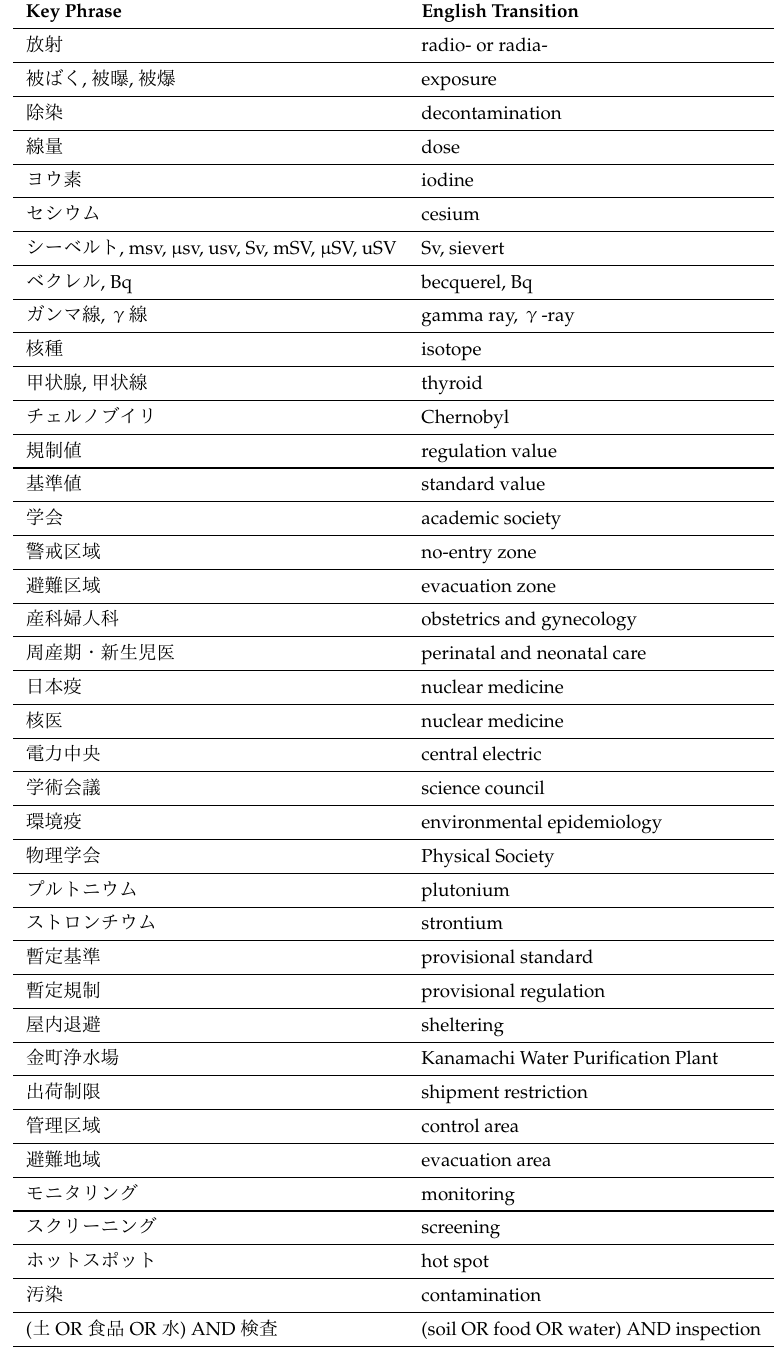
Table A1. List of key phrases used for extraction of the data set for this study as well as for the previous study